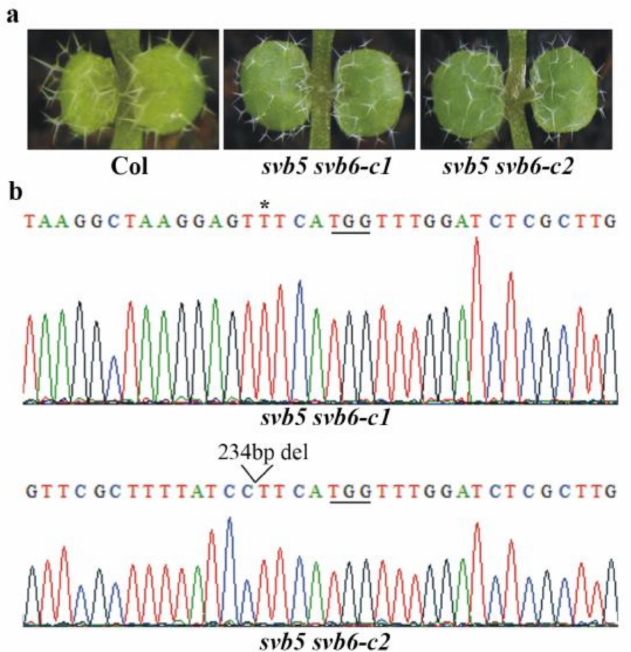
Figure 8. Mutation of SVB5 and SVB6 did not affect trichome development. ( a ) Trichome formation on the first two rosette leaves of the Col wild type, and the svb5 svb6 double mutants. Seeds of the Col wild type, the svb5 svb6-c1 and svb5 svb6-c2 double mutants were sown directly into soil pots and grown in a growth room, and trichomes on the first two rosette leaves of 8-day-old seedlings were examine under a Motic K microscope and pictures were taken by using an EOS 1100D digital camera connected to the microscope. ( b ) Editing status of SVB6 in the svb5 svb6-c1 and svb5 svb6-c2 double mutants. DNA was isolated from normal flowering T2 plants and used for sequencing. Underlines indicate the PAM sites, open arrow head indicates the site where a small fragments was deleted, and star indicates the single nucleotide insertion in the target sequence.